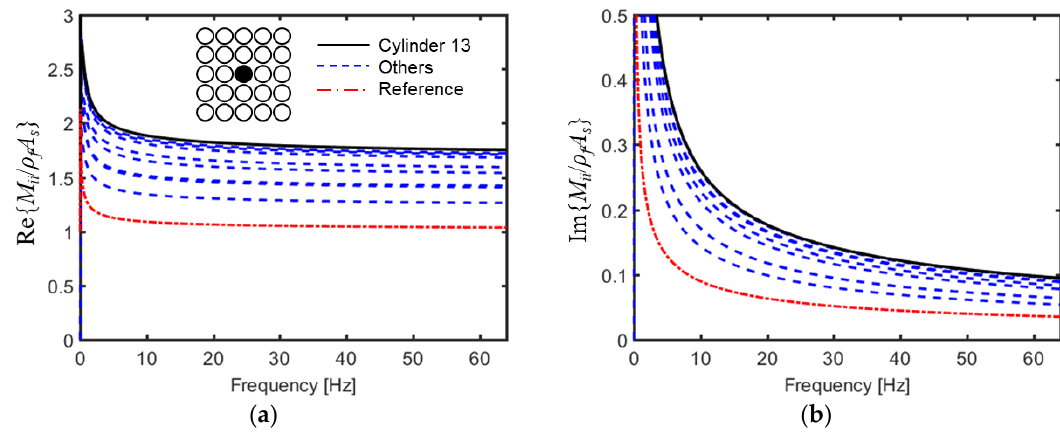
Figure 5. Calculated added comparison between exact solutions and calculated added masses of a single cylinder using Lin’s method: ( a ) real part and ( b ) imaginary part.